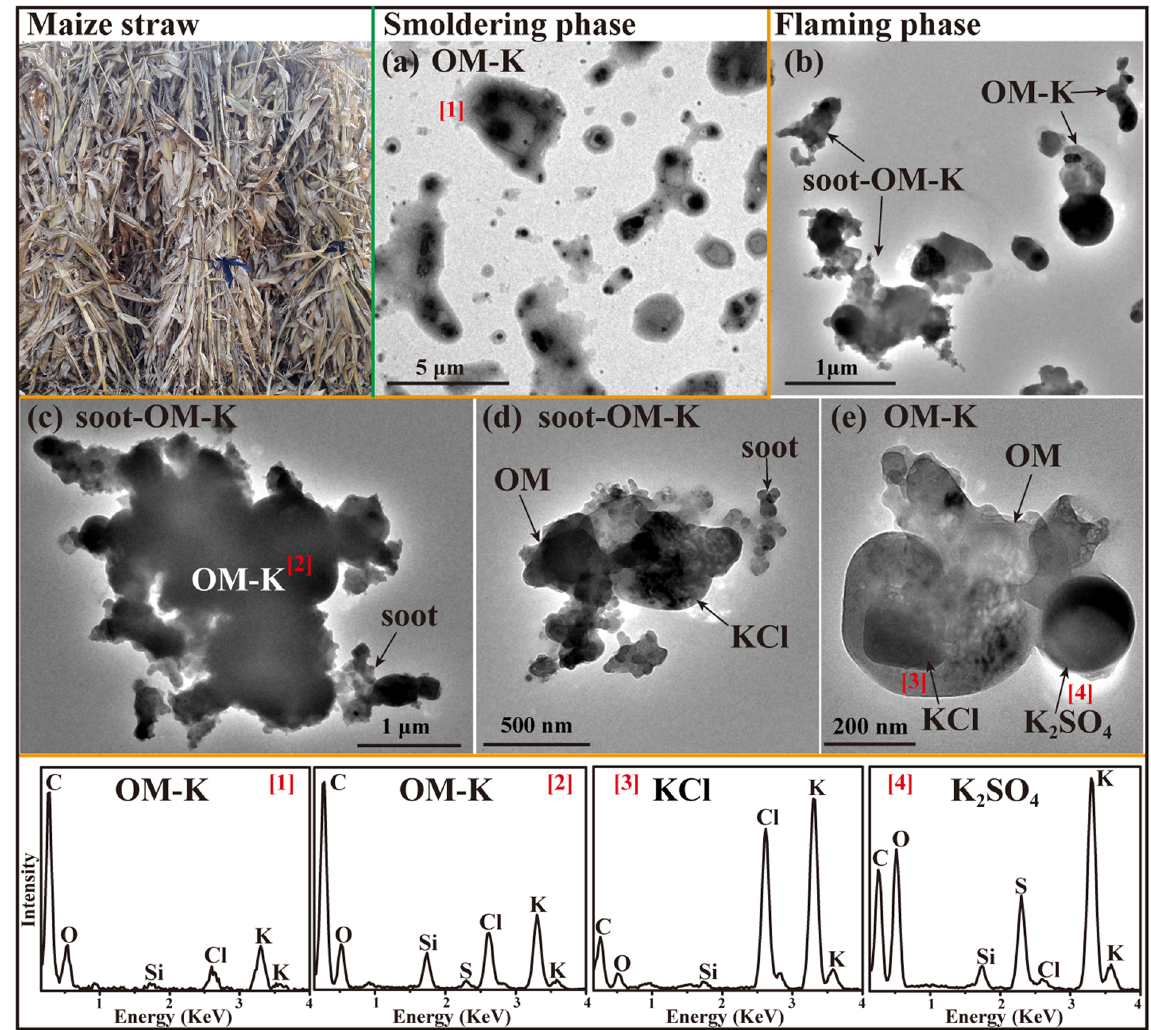
Figure 1. TEM images and EDS spectra of individual primary particles from the combustion of maize straw. ( a ) Low magnification TEM image of gel-like OM particles containing K-rich cores in the smoldering phase; ( b ) Low magnification TEM image of a mixture of OM-K and soot-OM-K particles in the flaming phase; ( c and d ) Soot particles internally mixed with OM and KCl in the flaming phase; ( e ) An OM-K particle including KCl and K 2 SO 4 cores in the flaming phase. The corresponding EDS spectra are indicated by the number in square